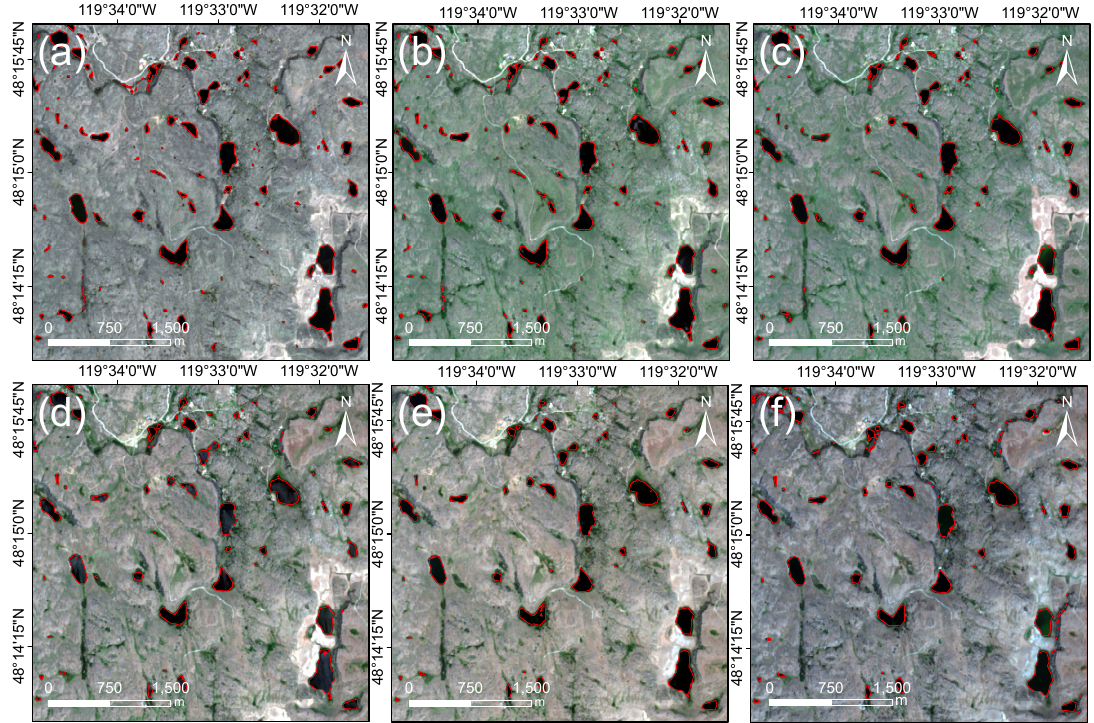
Figure 8. Examples of preprocessed optical images and reference data in which the water boundary is indicated as red lines: ( a ) Optical image taken on 25 April 2018, ( b ) Optical image taken on 23 May 2018, ( c ) Optical image taken on 19 June 2018, ( d ) Optical image taken on 22 July 2018, ( e ) Optical image taken on 8 August 2018 and ( f ) Optical image taken on 10 September